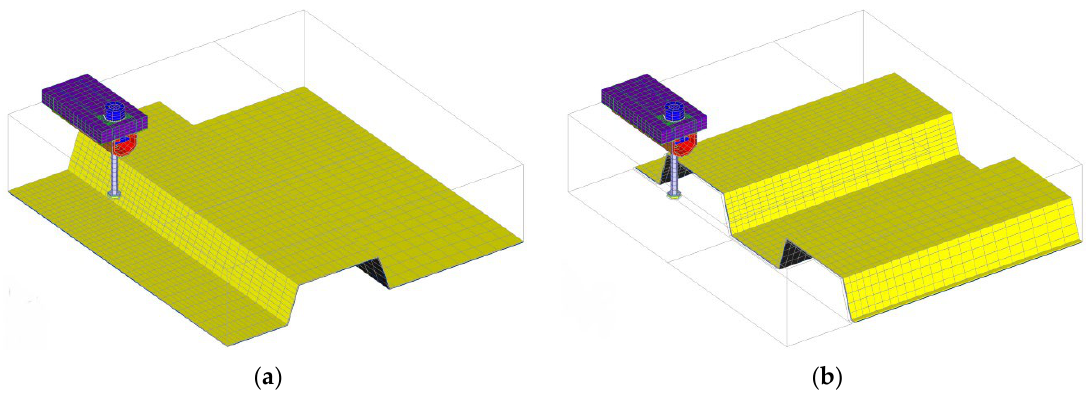
Figure 7. The geometry (model) representing: ( a ) Series 1; and ( b ) Series 2. Table 4. Series 2—anchor channel in the perimeter beam perpendicular to the steel decking.